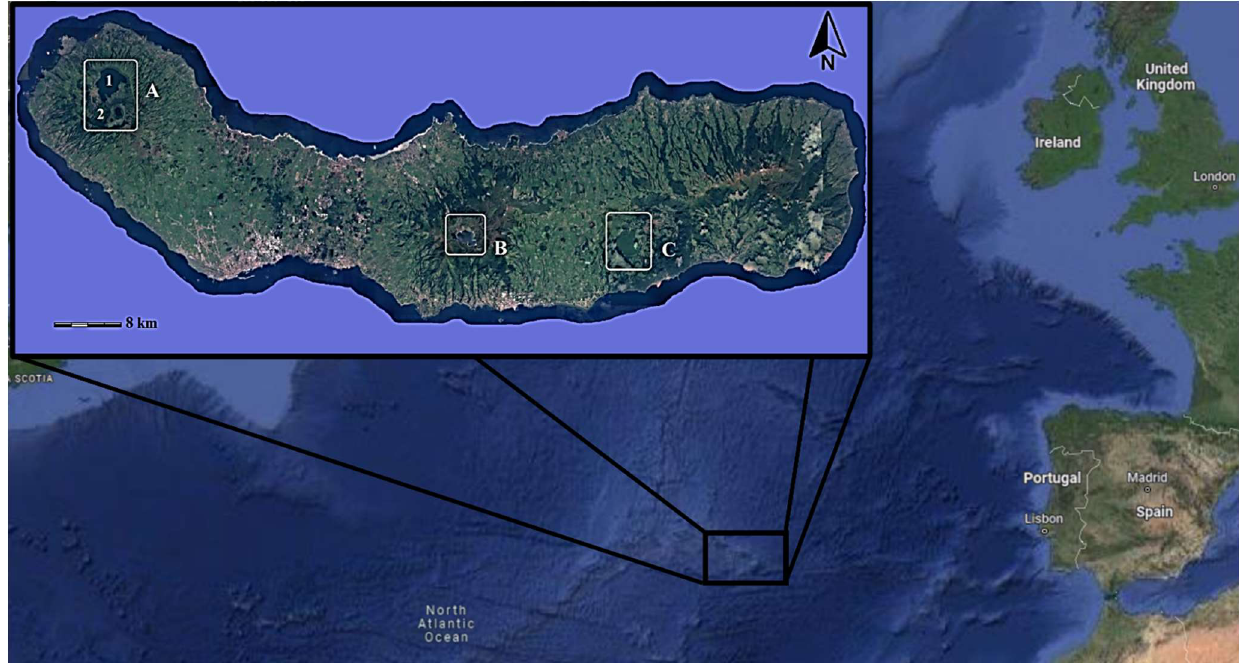
Figure 1. A map of S. Miguel Island (Azores) geographical location and, the location of the lakes under study. A—Sete Cidades Lake (1—Blue Lake; 2—Green Lake); B—Fogo Lake; C—Furnas Lake.